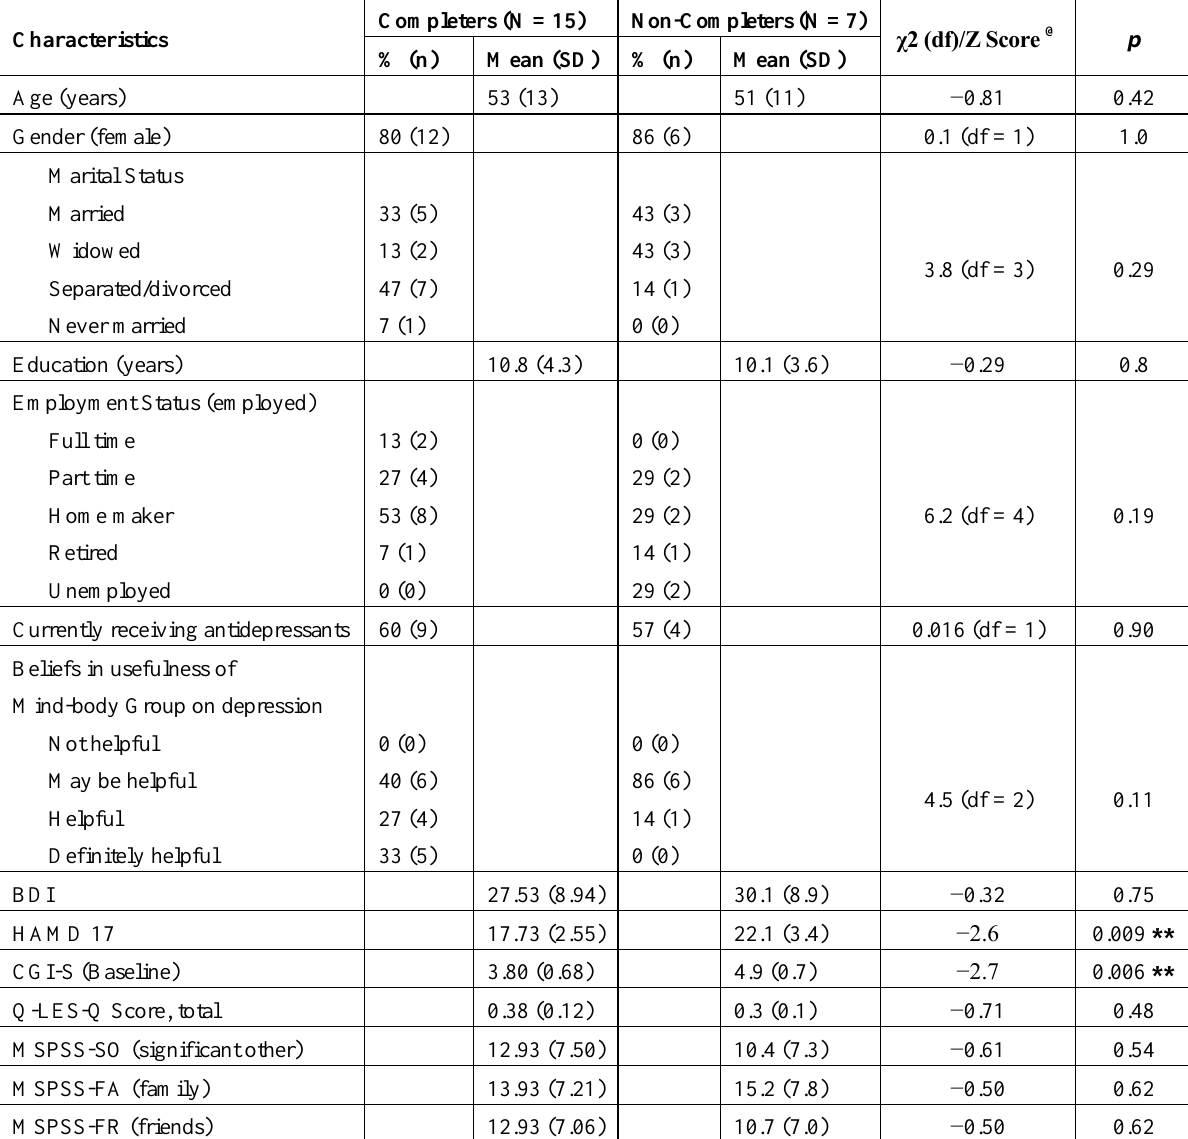
Table 2. Baseline characteristics of study participants (N =